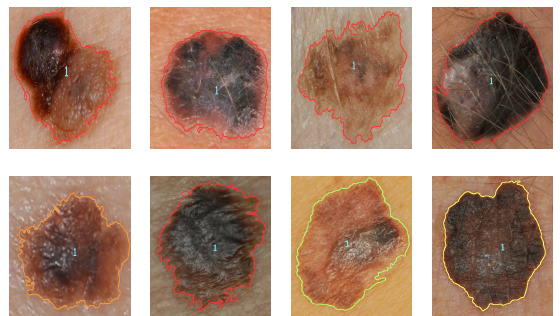
Figure 9. Examples of identification and classification of malignant melanoma cases in simple